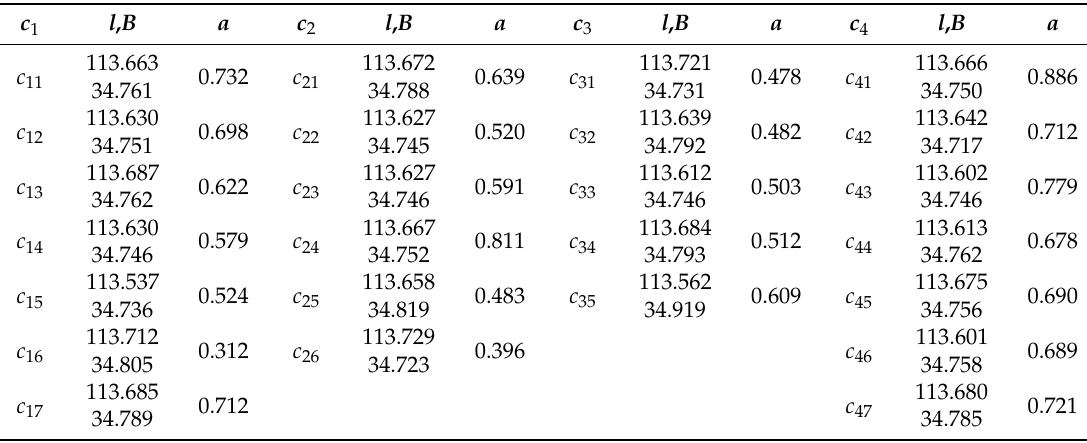
Table 2. Longitude and latitude ( l , B ) and attraction index a for tourist sites.